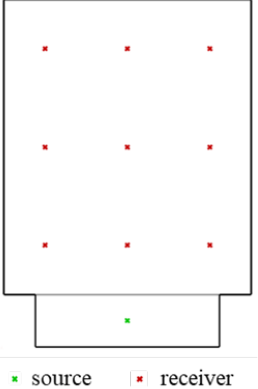
Figure 6. Source and receiver points. Table 2. Setting conditions of parametric model.